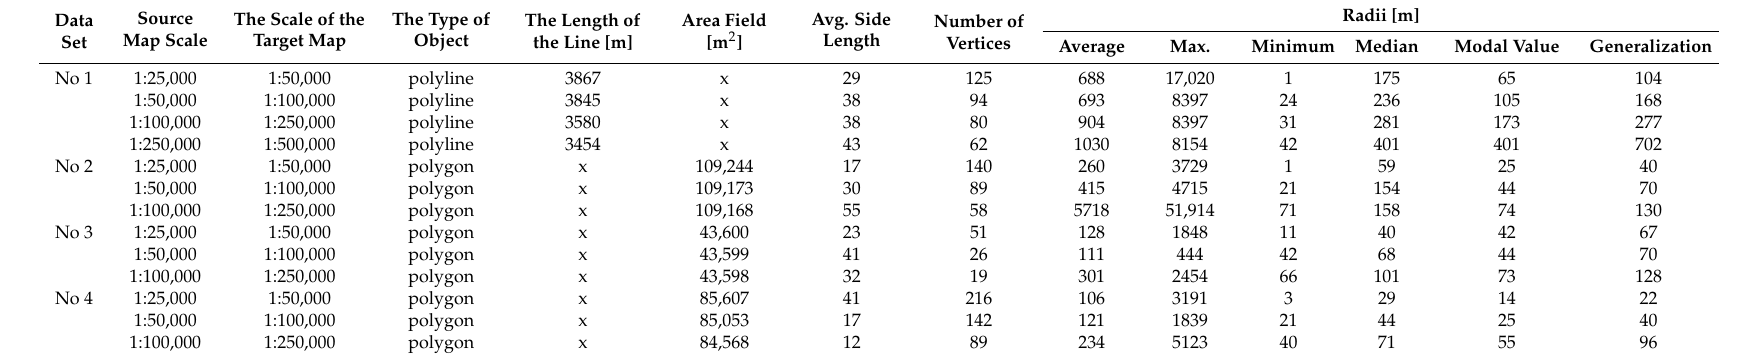
Table 1. Summary of statistical indicators of the analyzed data.